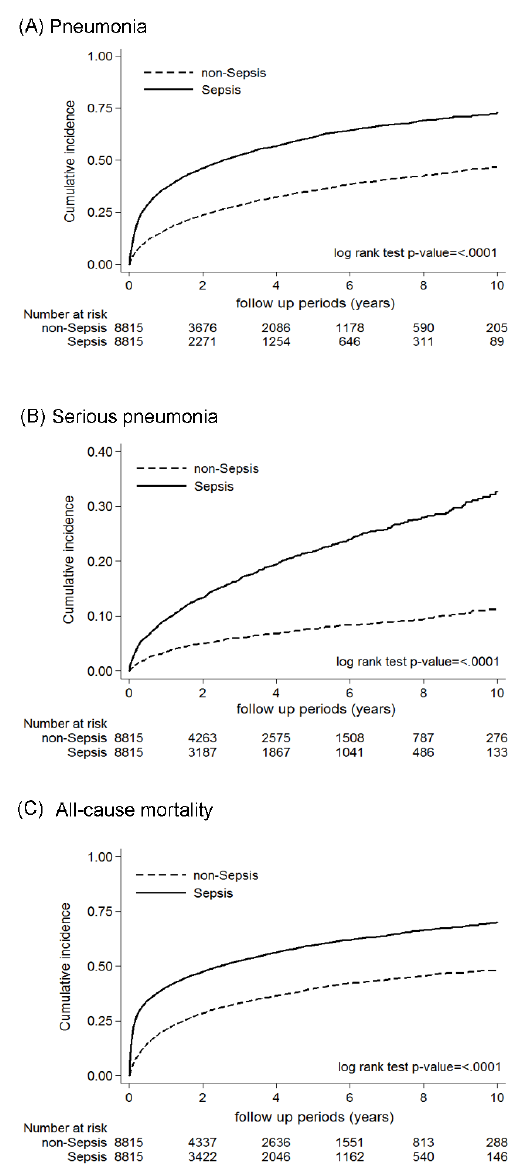
Figure 2. Kaplan-Meier analysis of the cumulative incidence for ( A ) pneumonia, ( B ) serious pneumonia and ( C ) mortality between the sepsis and non-sepsis cohort after matching.